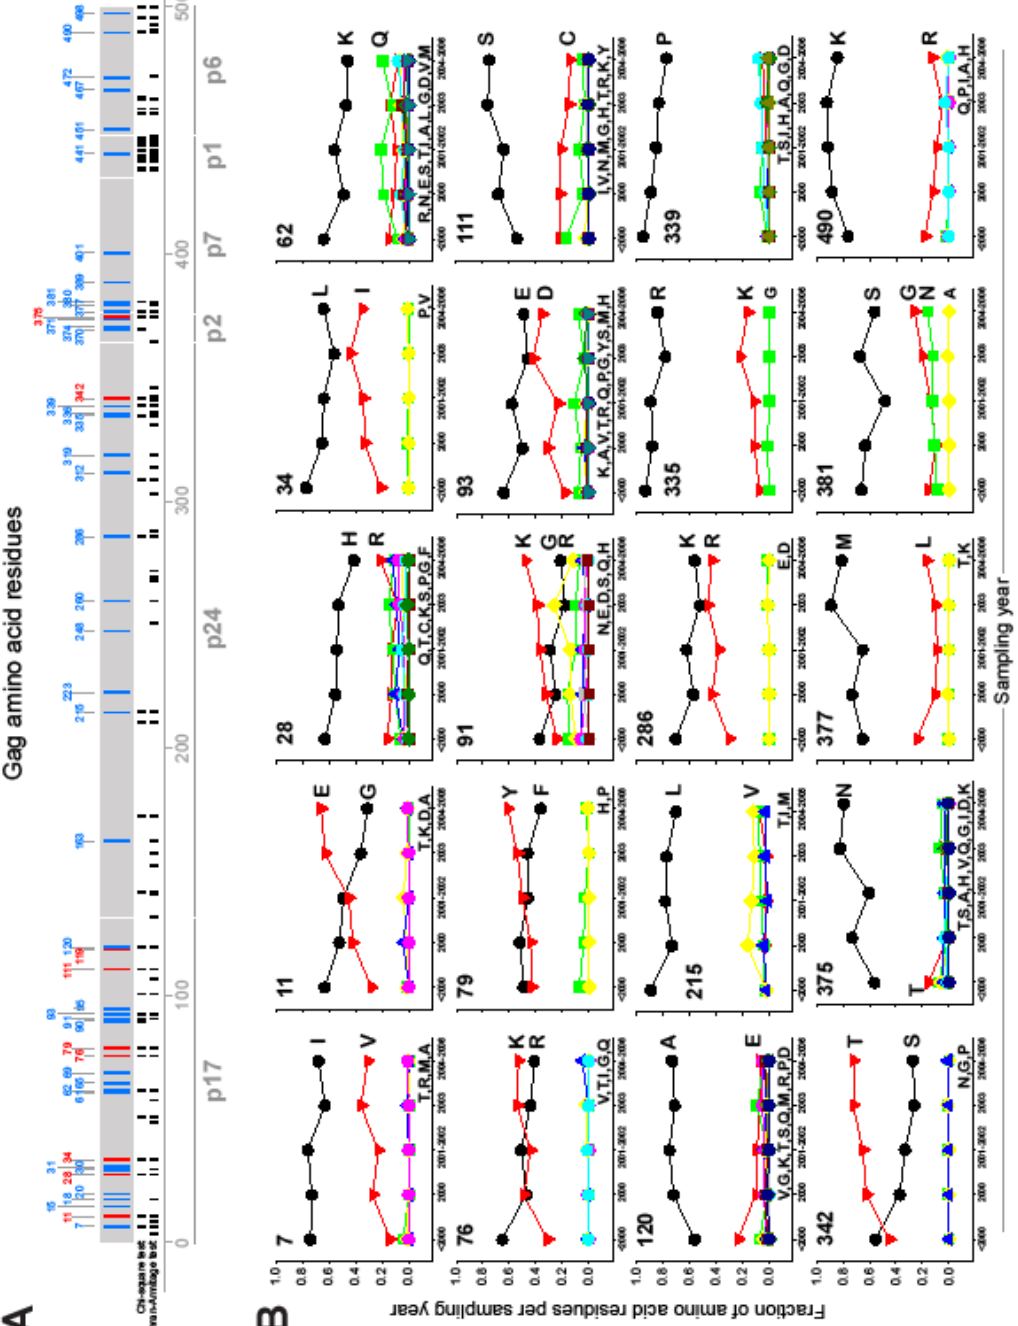
Figure 4. Changing amino acid residues in HIV-1 subtype C Gag. A: Overview of changing amino acid residues across Gag cleavage products. Location of changing amino acids is shown in relation to HXB2 numbering. Changing amino acid sites with frequency change of more than 20% are shown in red, and sites with frequency change between 10% and 20% are shown in blue. Location of changing amino acids detected by chi-square test and Cochran-Armitage trend test is depicted in black under the Gag bar. B: Dynamics of amino acid frequency at top 20 sites (significant changes by all three methods). Number in the upper left corner in each graph depicts location in relation to HXB2